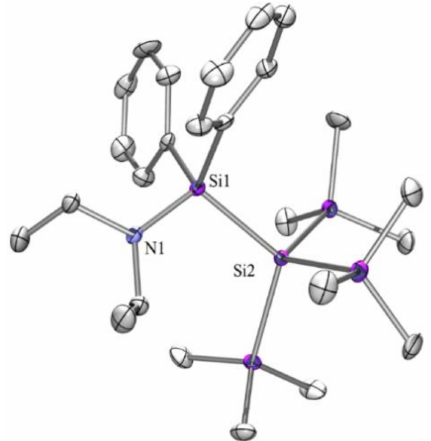
Figure 1. Molecular structure of compound 1 (thermal ellipsoid plot drawn at the 30% probability level). All hydrogen atoms are omitted for clarity (bond lengths in Å, angles in degrees). Si(1)-N(1) 1.717(3), Si(1)-C(1) 1.903(4), Si(1)-Si(2) 2.3744(14), Si(2)-Si(3) 2.3540(15), Si(2)-Si(4) 2.3657(15), Si(2)-Si(5) 2.3706(14), Si(3)-C(18) 1.870(5), N(1)-C(15) 1.458(5), N(1)-Si(1)-Si(2) 110.76(11), Si(3)-Si(2)-Si(4)